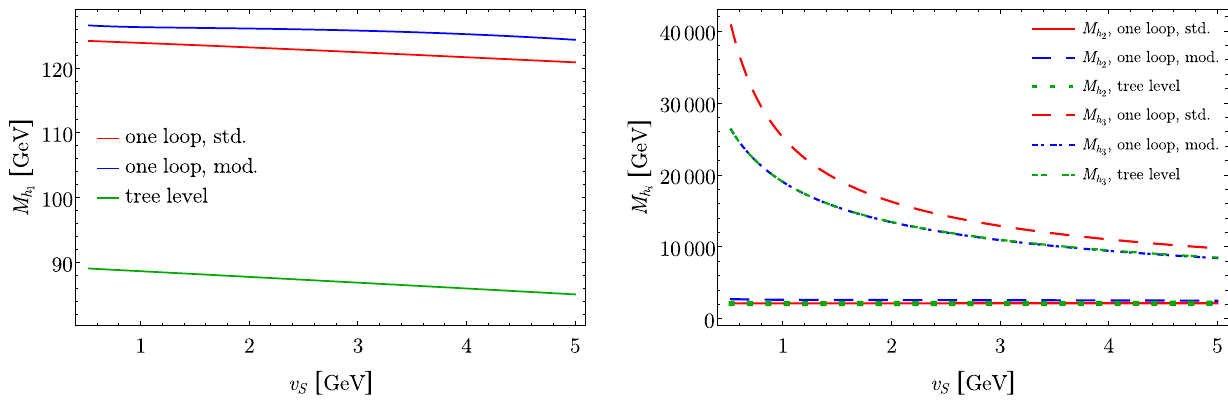
Fig. 13 M h (left) and M h and M h (right) as a function of v S , in scenario 3. The values of the other relevant inputs are given in Table 1 2 3